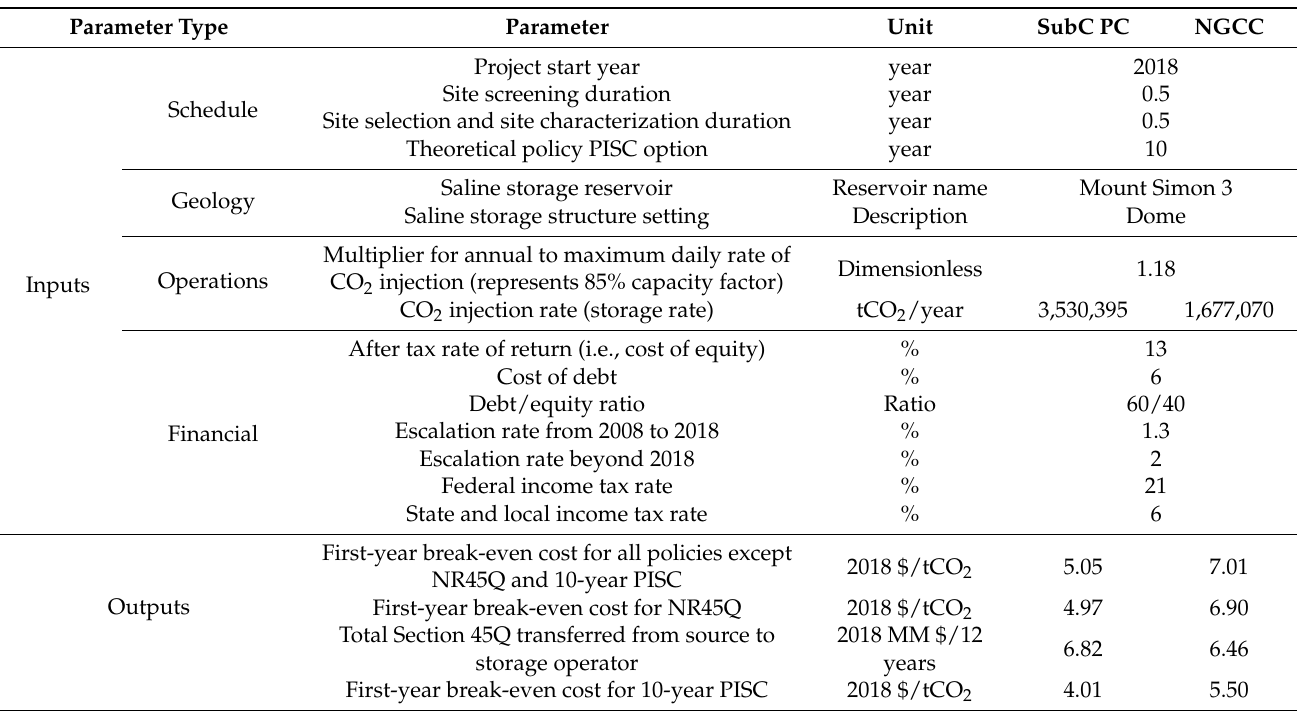
Table A4. Critical parameters and key outputs for CO 2 _S_COM runs in the